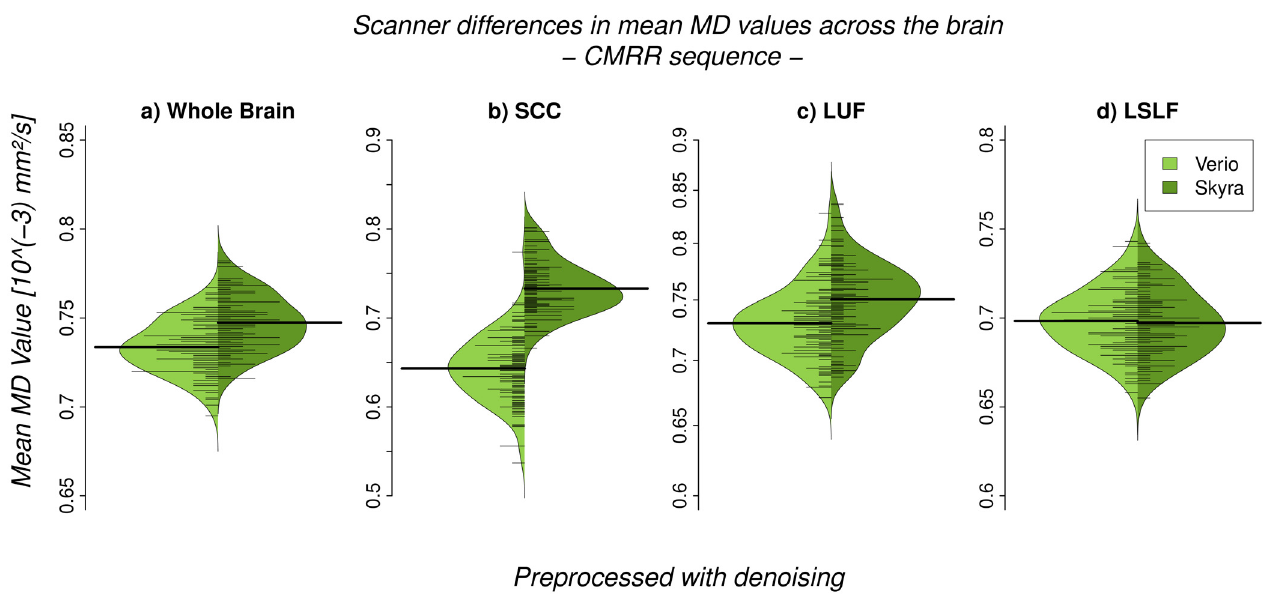
Figure 5. Scanner differences in the mean MD value of the white matter (WM) skeleton (CMRR sequence, after denoising) for ( a ) whole brain and region-of-interest analyses ( b – d )). ( a ) On the whole brain level, Skyra delivers higher MD values than Verio (~2%, BF >> 3). ( b ) The splenium of the corpus callosum (SCC) and ( c ) the left uncinate fascicle (LUF) show as well higher MD values for Skyra (SCC: ~14% (BF >> 3), LUF: ~3% (BF >> 3)). ( d ) Only in the left superior longitudinal fascicle (LSLF) scanner differences are not pronounced: ~ − 0.2% (BF = 0.16). Percentages reflect relative differences between ( Skyra ) − mean MD value ( Verio ) (cid:4666)(cid:3020)(cid:3038)(cid:3052)(cid:3045)(cid:3028)(cid:4667)(cid:2879)(cid:3040)(cid:3032)(cid:3028)(cid:3041) (cid:3014)(cid:3005) (cid:3049)(cid:3028)(cid:3039)(cid:3048)(cid:3032) (cid:4666)(cid:3023)(cid:3032)(cid:3045)(cid:3036)(cid:3042)(cid:4667) × scanners: mean MD value × 100 .